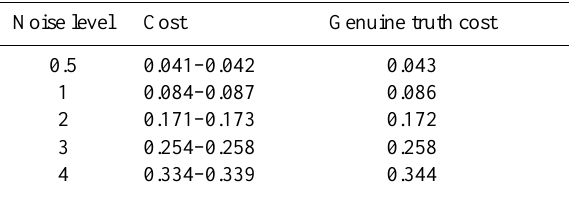
Figure 5. Temporal evolution of the model–data misfit (Eq. 9). The model–data misfit measures the difference between the genuine truth and a simulation where the “truth” parameter set (Table 3) is modified by multiplying H N , H PAR and µ by 4, 3 and 3.6, respec- tively. The black (red) line refers to simulations driven by OPTI (SENSI). Table 4. Costs (range enveloped by all five ensemble members) for differing noise levels in the NOISE experiments (mmolNm − 3 ). Two outliers were